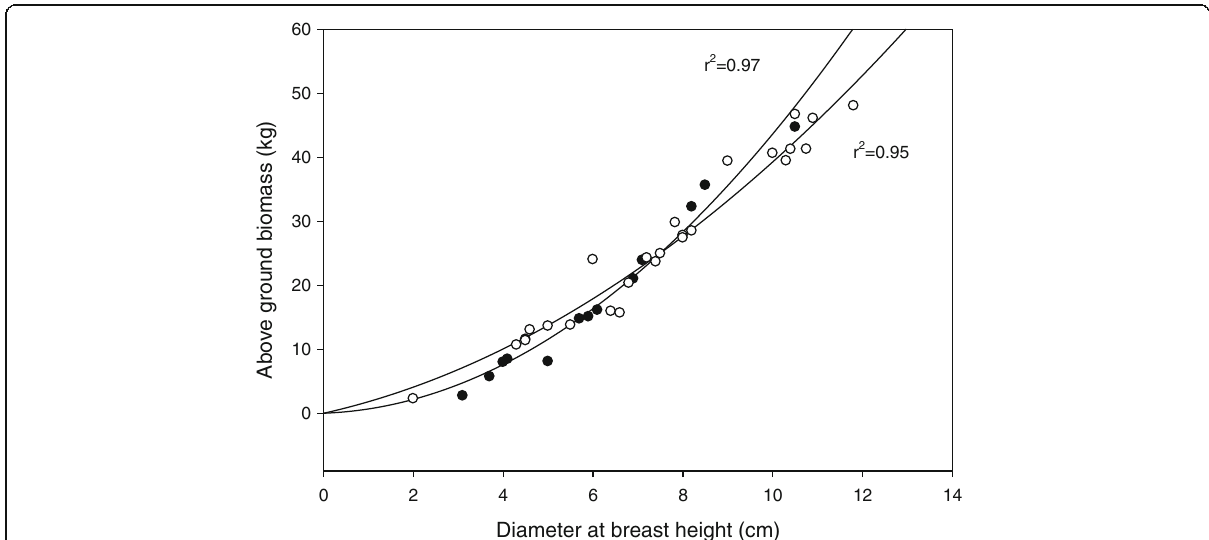
Fig. 2 Regression lines of total dry biomass (in kg) versus diameter at breast height (DBH) (open circles) for Juniperus procera and (filled circles) for Acacia abyssinica